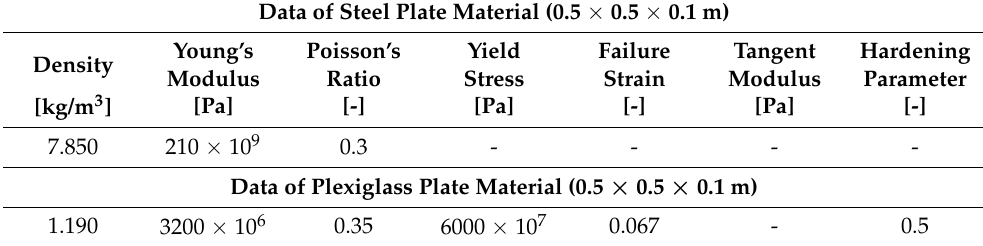
Table 2. Material data used in